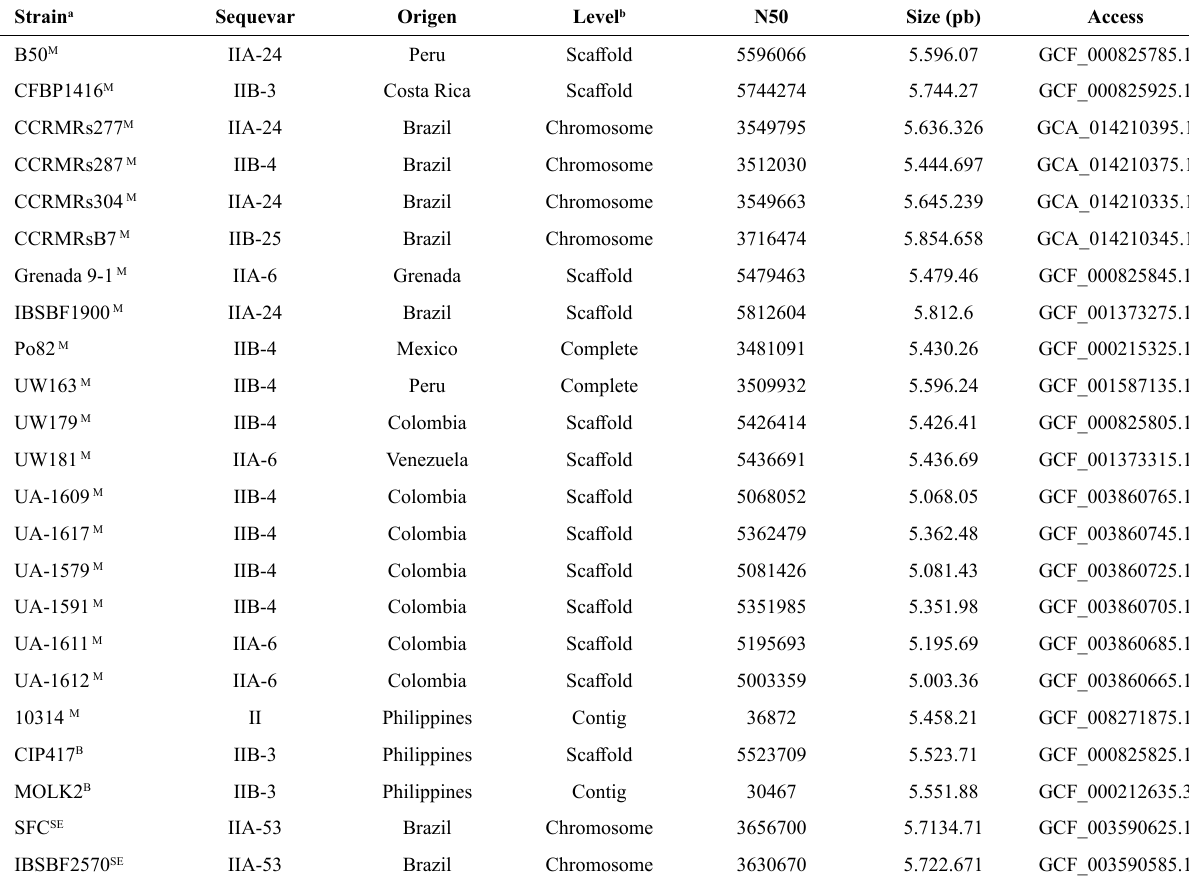
Table 1 – Characteristics of Ralstonia solanacearum Moko ecotype strains and its symptomatological variants used in this study. Strain a